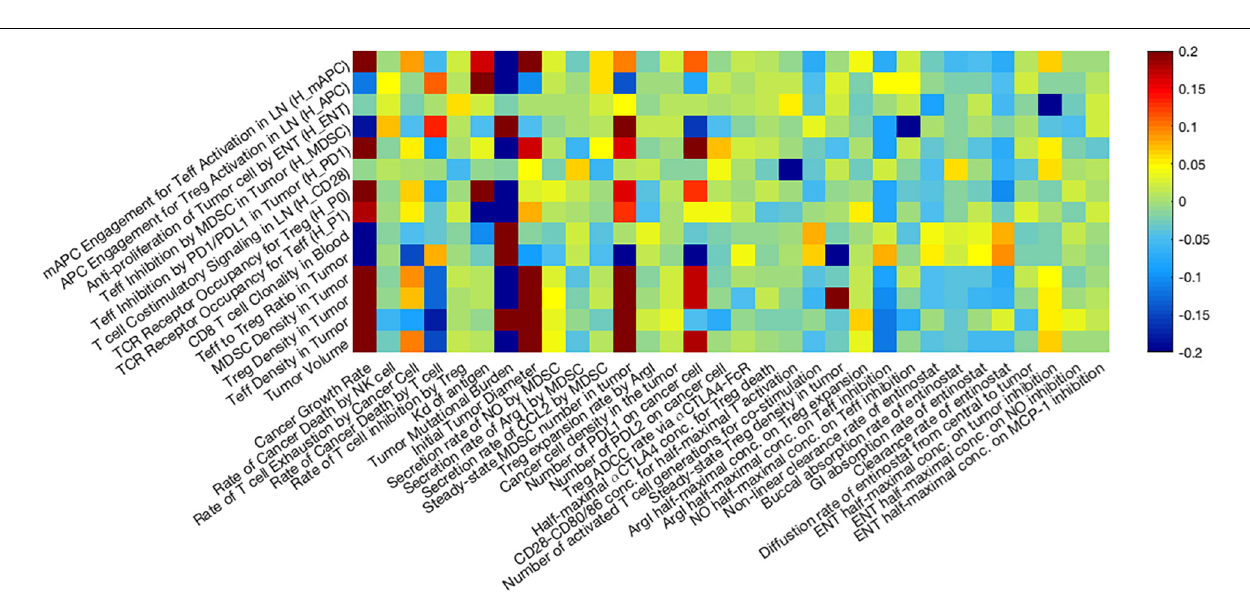
FIGURE 6 | Changes of cell density and tumor volume in dose escalation as post- to pre-treatment ratios, including Teff to Treg ratio (A) and their densities in tumor (B,C) , and tumor volume (D) . p -values are calculated using Wilcoxon test.